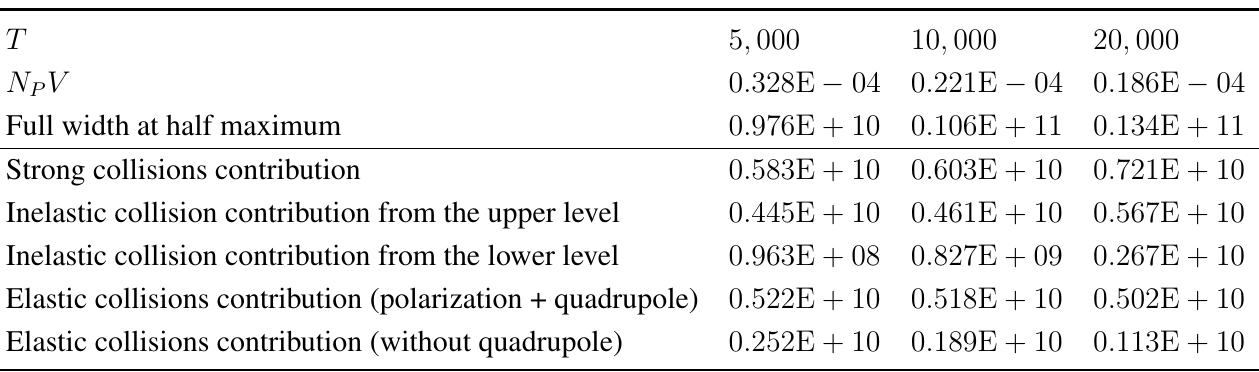
Table 5. Results of the SCP code for Li I 2 s − 2 p , electron collisions. Angular frequency = 10 16 cm − 3 , temperatures T in Kelvin. units, density N P